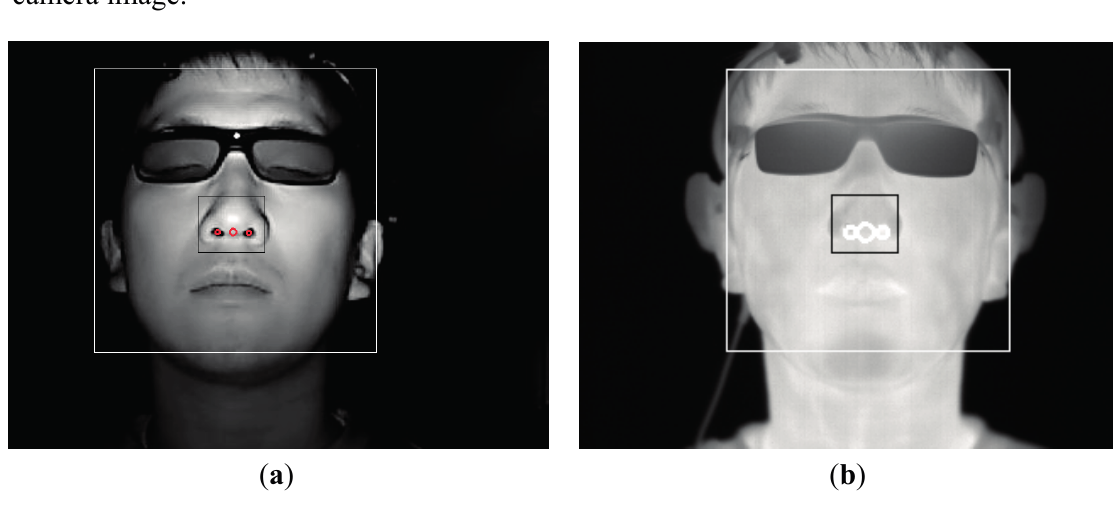
Figure 7. Example of the measurement region for variation of